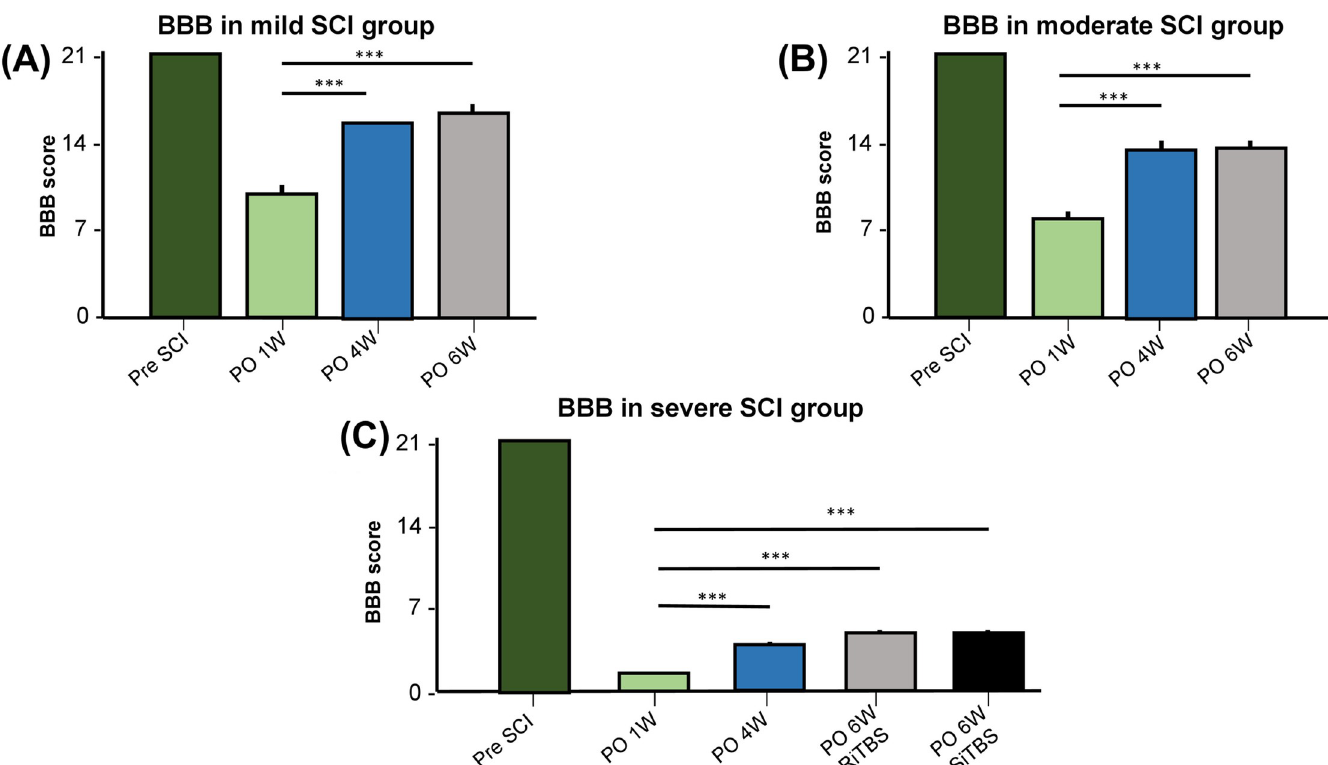
Fig 5. Time course of average changes in Basso Beattie Bresnahan (BBB) scores. In rats with mild (A), moderate (B), and severe spinal cord injury (SCI) (C) and intermittent theta-burst stimulation (iTBS) treatment. ��� p < 0.001, by post-hoc LSD multiple-comparison tests on the locomotor function between different points.